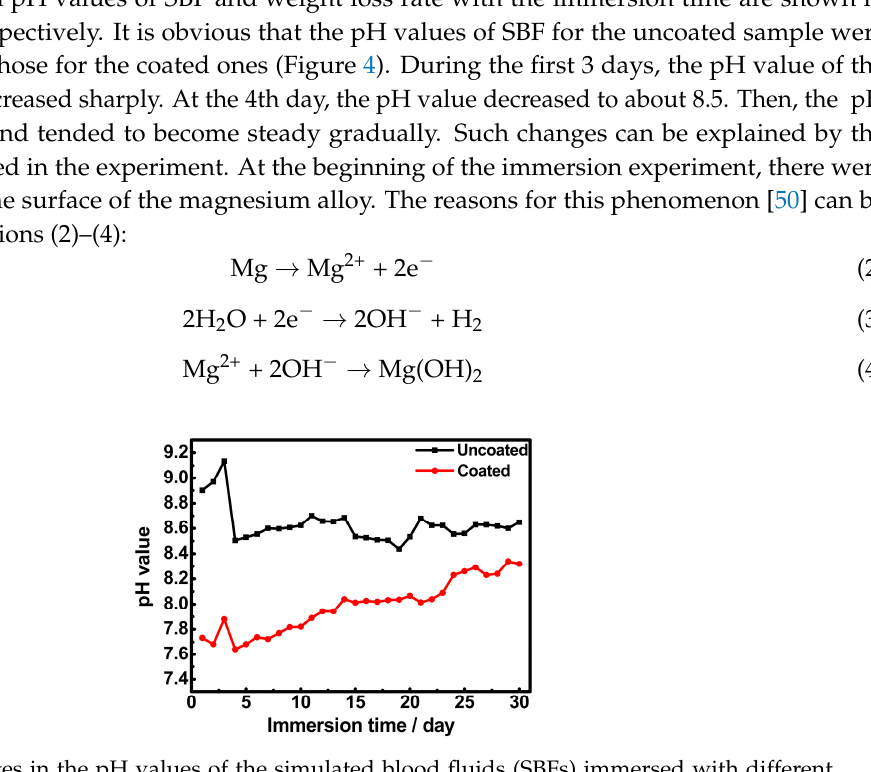
Figure 4. Changes in the pH values of the simulated blood fluids (SBFs) immersed with different samples over time.